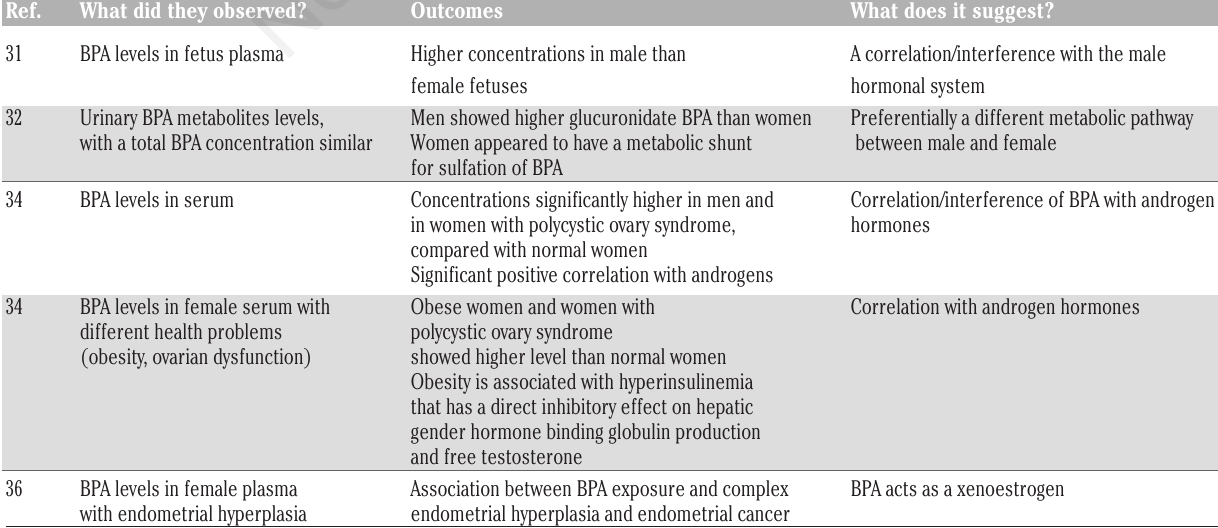
Table 1. Data about human exposure to bisphenol A.